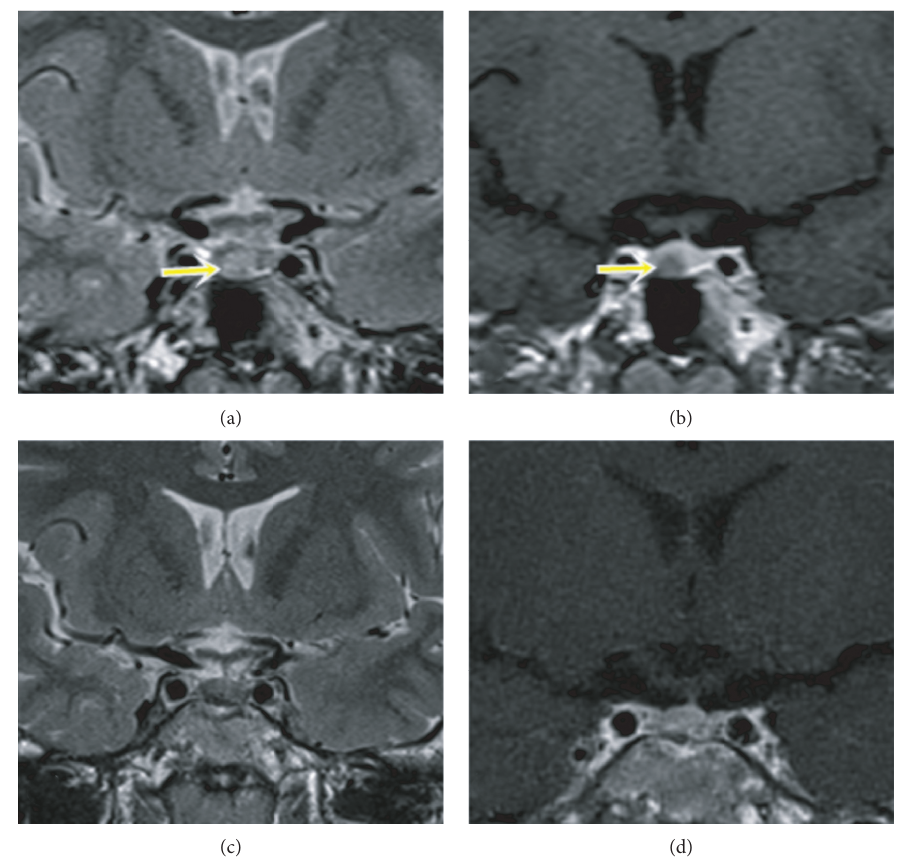
Figure 2: Preoperative (a, b) and postoperative (c, d) pituitary MRI results. Coronal T2-weighted image (a) and T1-weighted image with contrast enhancement (b) showed a pituitary lesion that was hyperintense on T2-weighted image and hypoenhancing compared with the surrounding pituitary parenchyma on T1-weighted image (arrows). The postoperative pituitary MRI showed no evidence of recurrence (c, d).